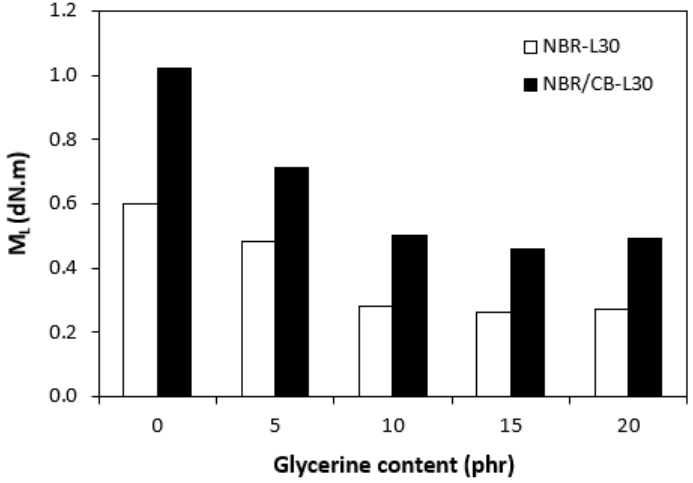
Figure 3. Influence of glycerine contents on minimum torques M L of rubber compounds.